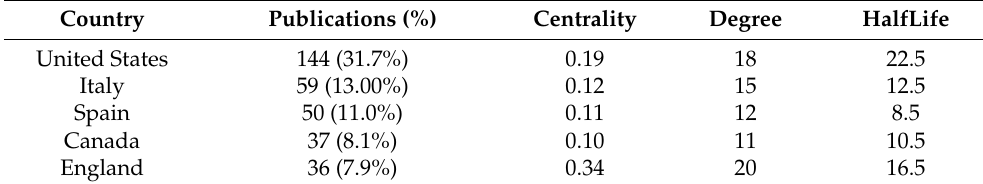
Table 1. Countries with the largest number of